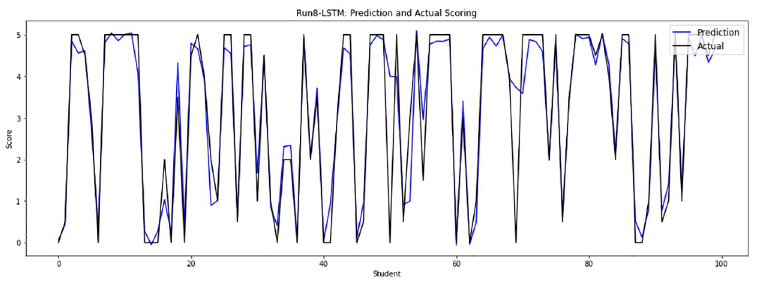
Fig 13. LSTM-GWO prediction and actual scores with experiment